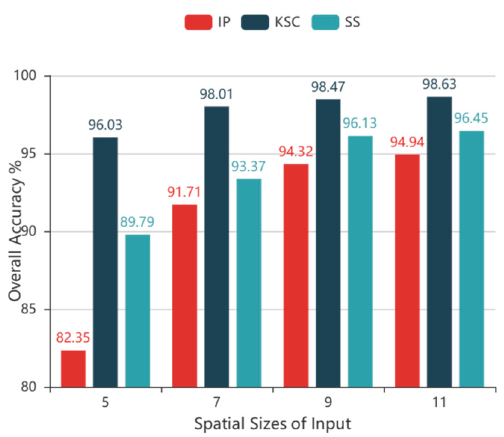
Figure 8. The overall accuracy of the AUSSC with different input spatial sizes.